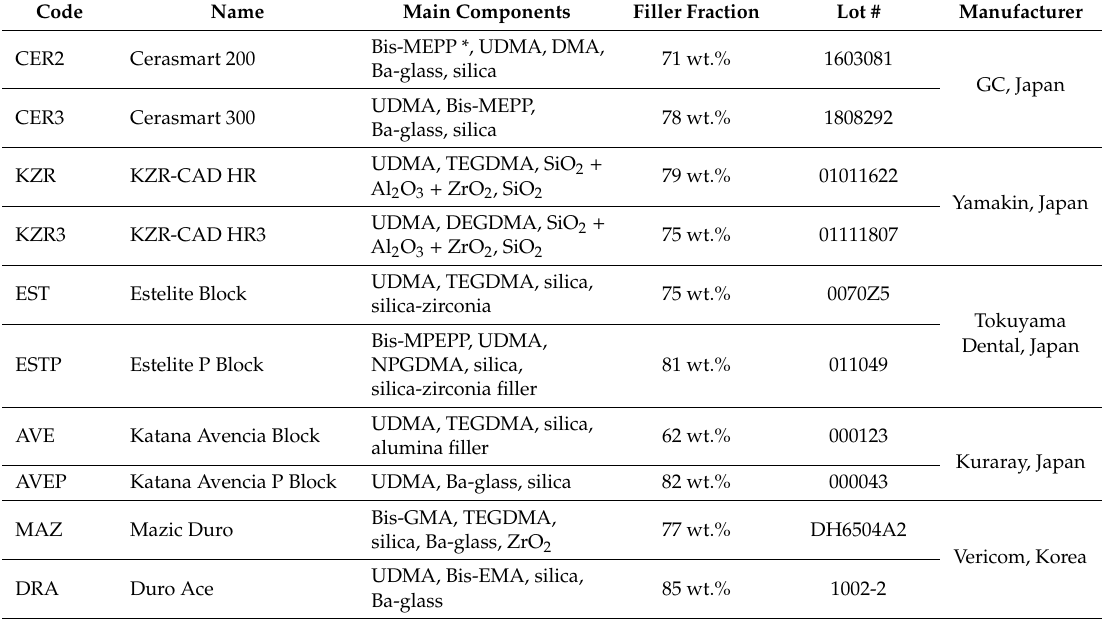
Table 1. Computer-aided design / computer-aided manufacturing (CAD / CAM) hybrid composite resin blocks used in this